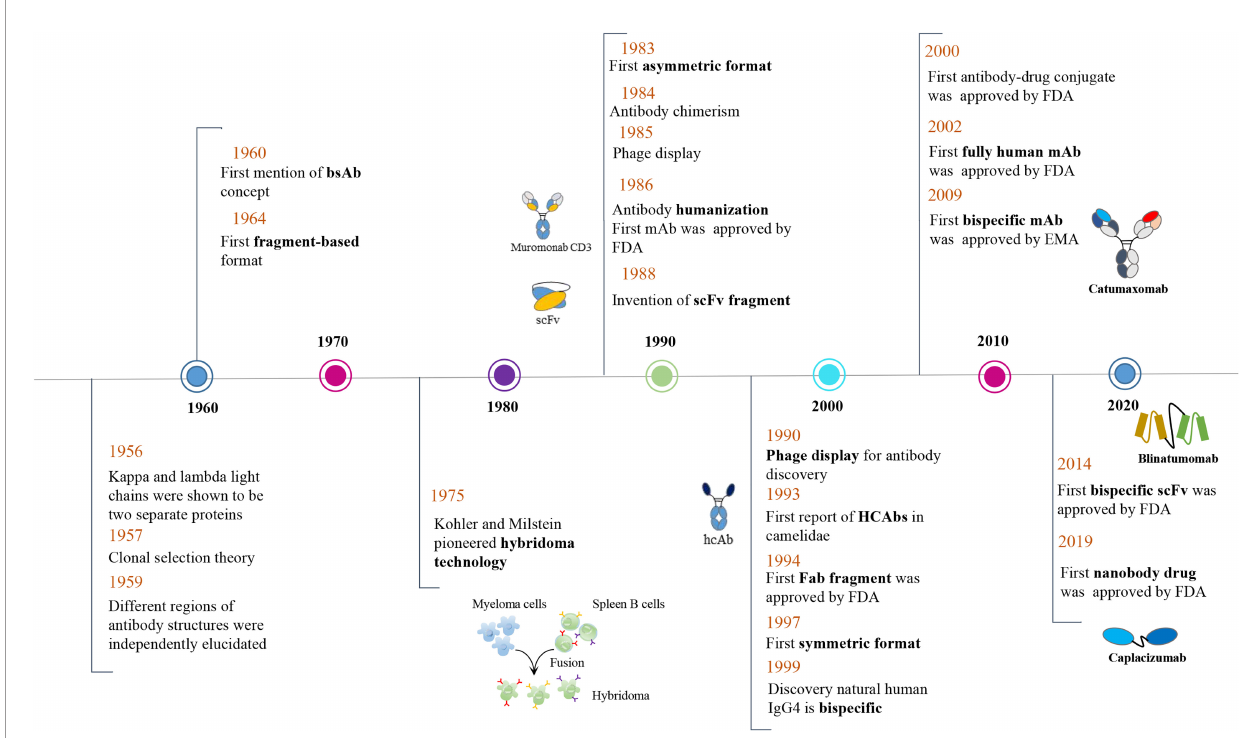
FIGURE 3 | Overview of the publications dedicated to BsNbs. Number of published papers reported in PubMed dedicated to studies describing the use of multispeci fi c/multivalent nanobodies and grouped according to the addressed